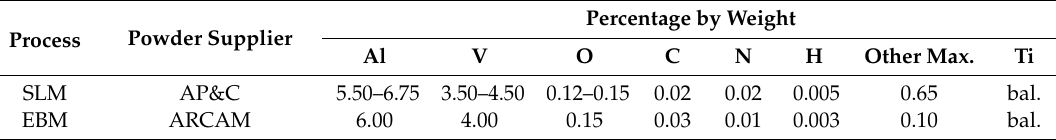
Table 3. Chemical composition * of stock Ti-6Al-4V Grade 5 powders. Process